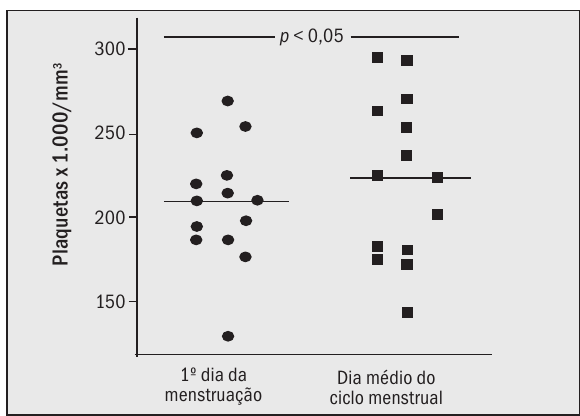
Figura – Número de plaquetas (x 1.000/mm 3 ) determinado em contador eletrônico (Coulter T-890). A linha horizontal representa a média dos valores